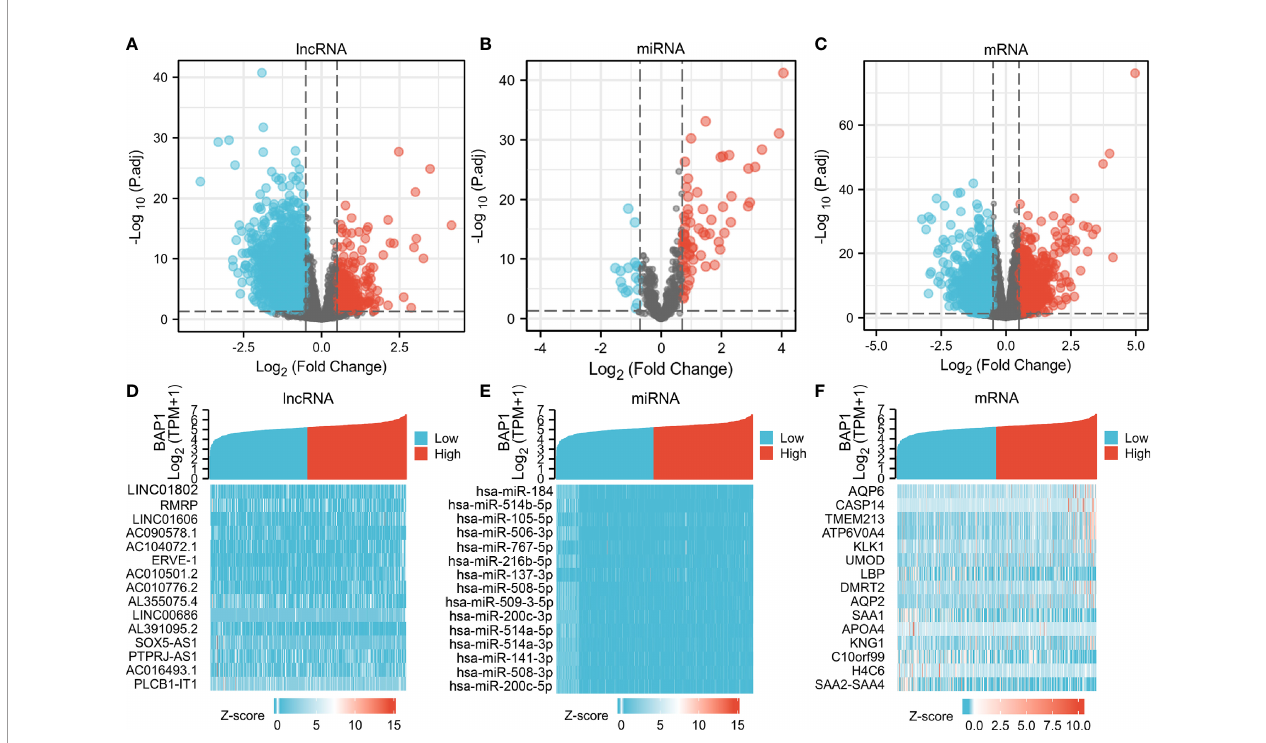
FIGURE 3 | Volcano plots and heatmap plots of DElncRNAs, DEmiRNAs, and DEmRNAs between the expression of BAP1high and BAP1low in KIRC samples. Red color represents up-regulated genes, blue represents down-regulated genes. (A) 3425 DElncRNAs (|log2 FC| > 0.5 and P. adj < 0.05); (B) 84 DEmiRNAs (|log2 FC| > 0.7 and P. adj < 0.05); (C) 2753 DEmRNAs with cutoff value of |log2 FC| > 0.5 and P. adj < 0.05; (D – F) Heatmaps of the top 15 signi fi cant DElncRNAs, miRNAs and